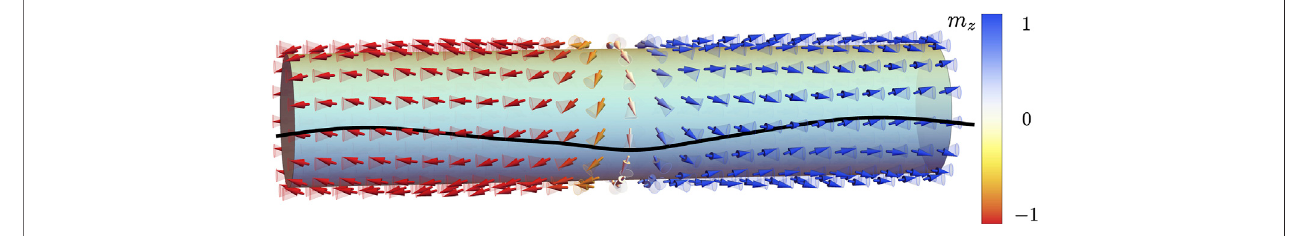
FIGURE 1 | A ferromagnetic nanotube with a domain wall possessing fi nite Skyrmion charge and magnetic textures with spin-wave fl uctuations. The arrows represent magnetizations of spin-wave excitations. The transparent cones represent swapped regions by fl uctuations of the magnetizations. The black curve lines the heads of the arrows. The axis of the nanotube is the z